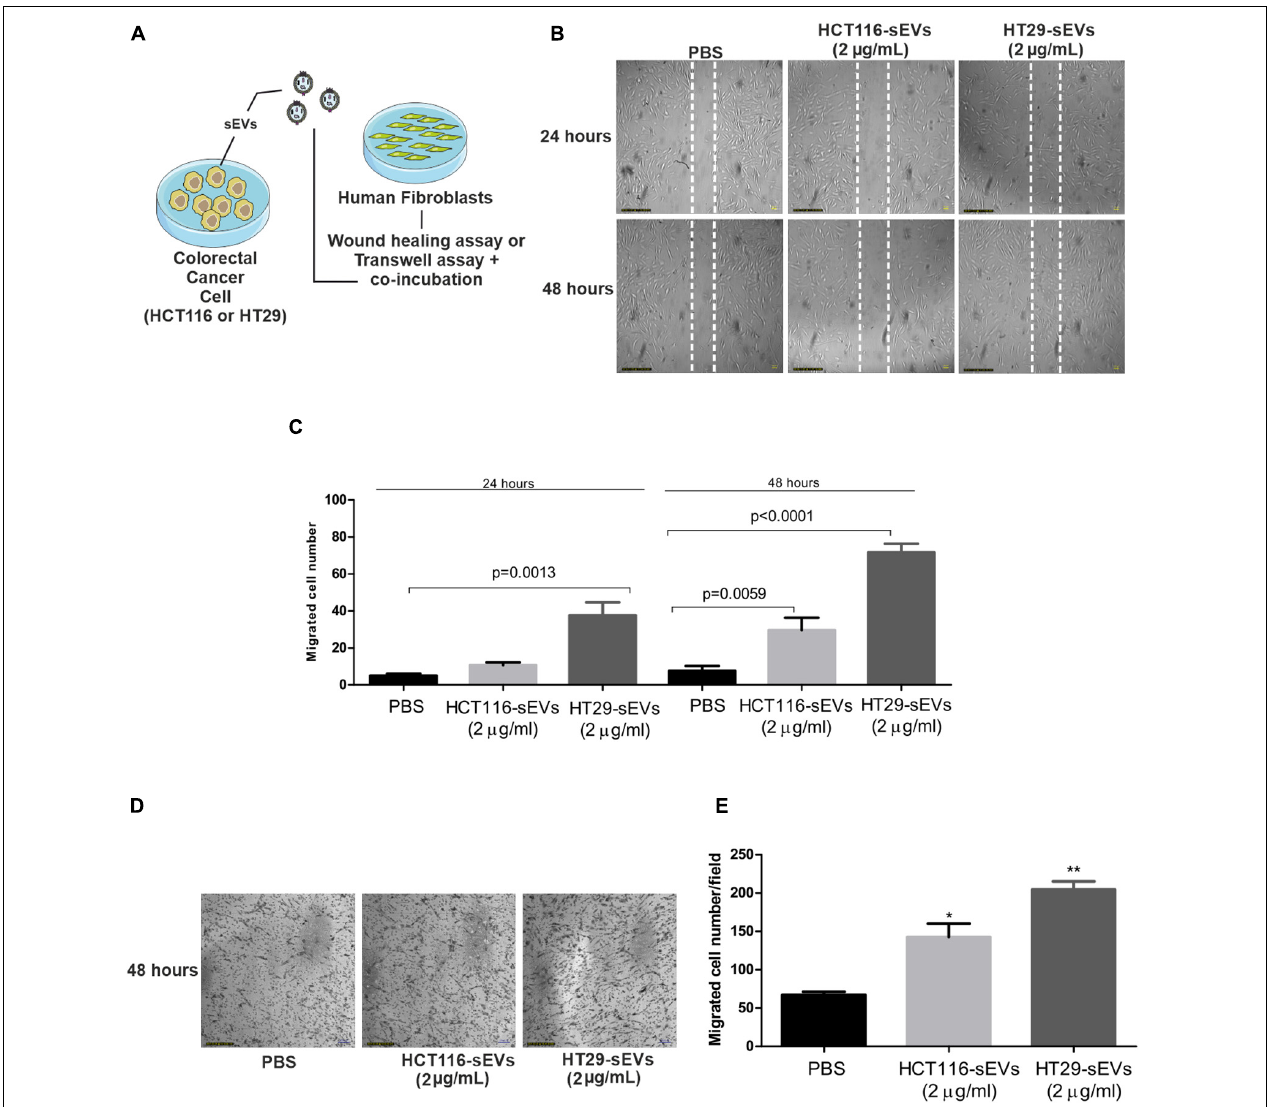
FIGURE 4 | sEVs increase human fibroblast cell migration. (A) Schematic diagram of experimental procedures. For wound healing assay, 1 × 10 4 human fibroblasts were cultured and serum-starved for 24 h. Scratch was made using a pipette tip, and cells were exposed to HCT116 and HT29 cell-derived sEVs (2 µ g/ml) or vehicle (PBS) for 24 and 48 h. (B) Representative photographs of wound healing assay. (C) Quantification of migrated cells. For Transwell assay, human fibroblasts (1 × 10 5 ) were incubated for 48 h with HCT116 and HT29 cell-derived sEVs (2 µ g/ml) or vehicle (PBS) in serum-free medium. Treatments were incubated both in upper and lower chambers. After 48 h of incubation, migration activity was quantified by counting migrated cells on lower surface of membrane of at least five fields per chamber of a Transwell using a × 10 objective. (D) Representative photographs of Transwell migration assay. (E) Quantification of migrated cells. All values are representative of mean of at least two independent experiments with similar results and are displayed as mean ± SEM, where * P < 0.05 and ** P < 0.01, assessed with Student t